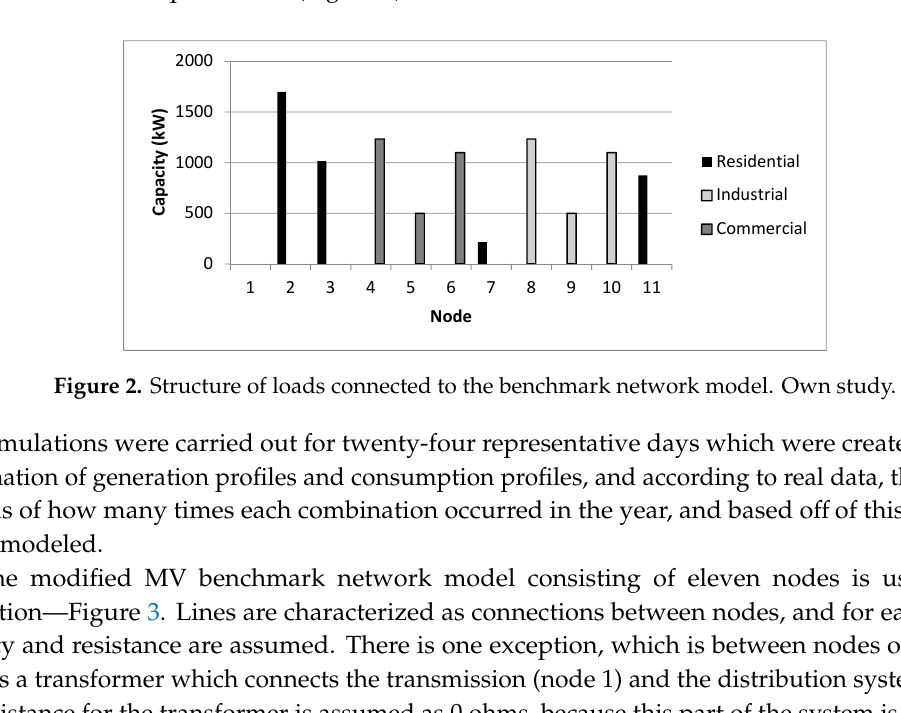
Table 1. Rated power of the renewable energy sources (RES). 210